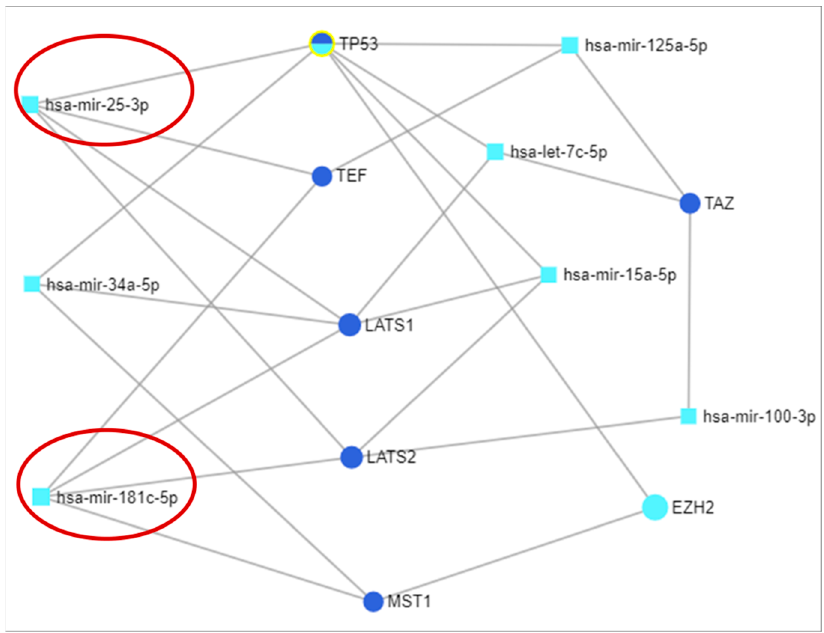
Figure 5. mRNA-miRNA interconnected network generates using miRNET. Red circles are high- lighted miRNA selected for qRT-PCR validation.